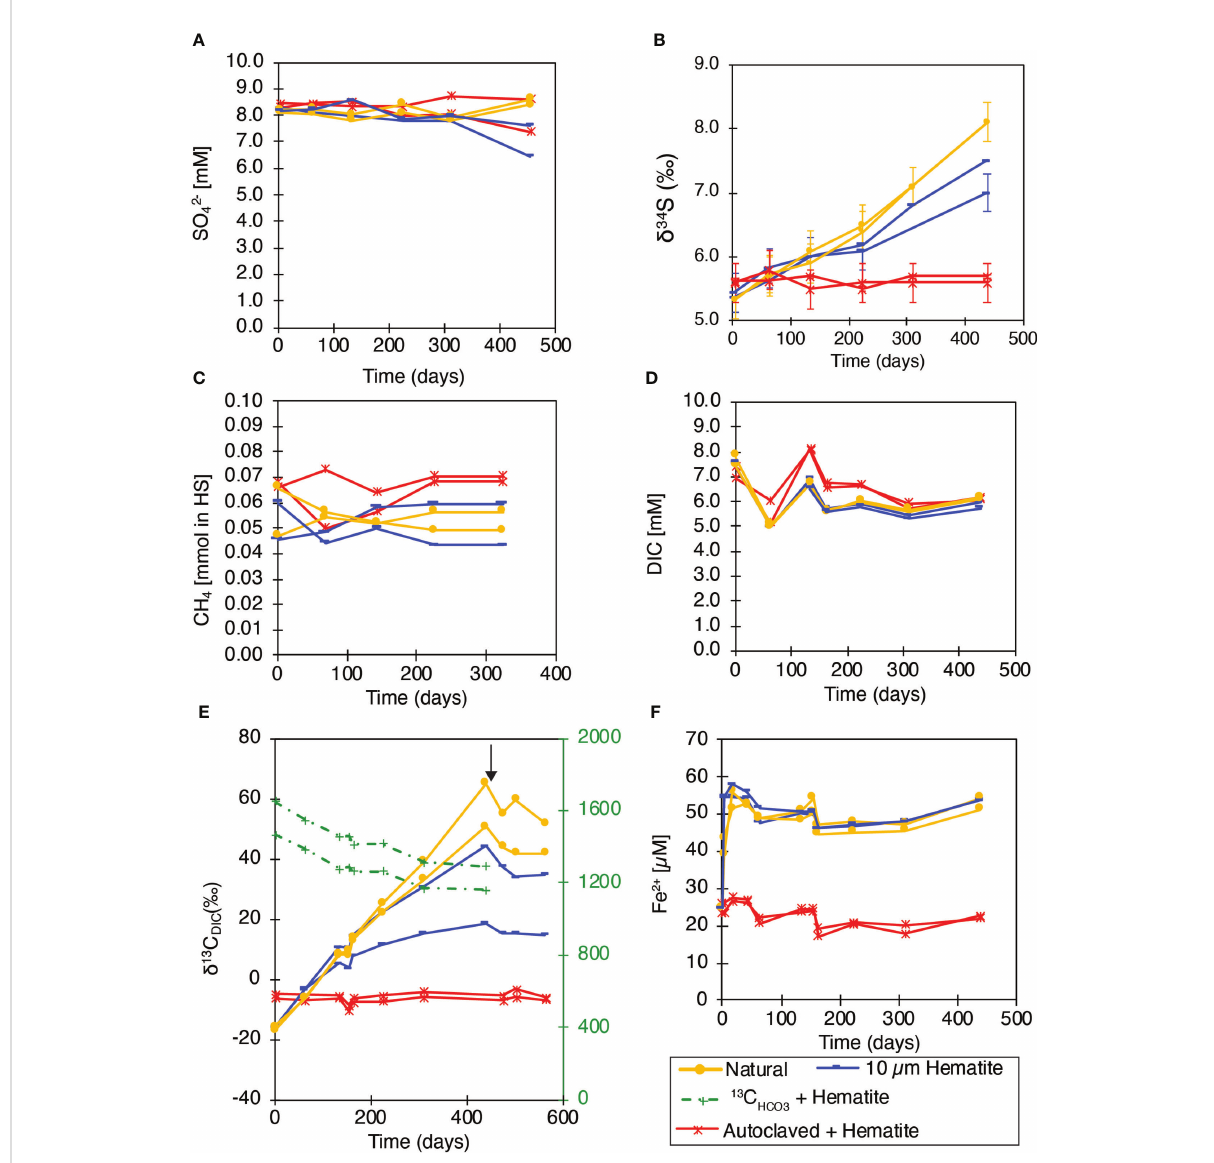
FIGURE 3 MS slurry incubations experiment. (A) SO 4 2- concentrations; (B) d 34 S SO4 ; (C) CH 4 concentrations; (D) DIC concentrations; (E) d 13 C DIC ; (F) dissolved Fe